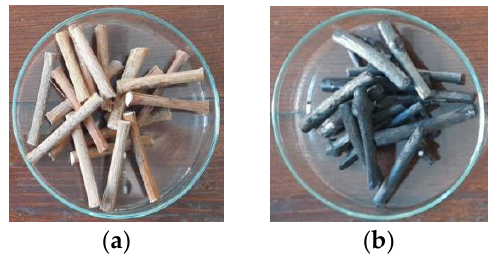
Figure 1. Chopped vine pruning residue ( a ) and BC ( b ).